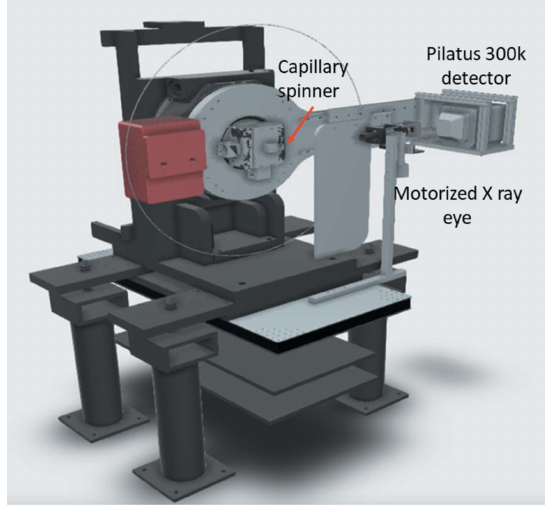
Figure 2 The MS beamline two-circle